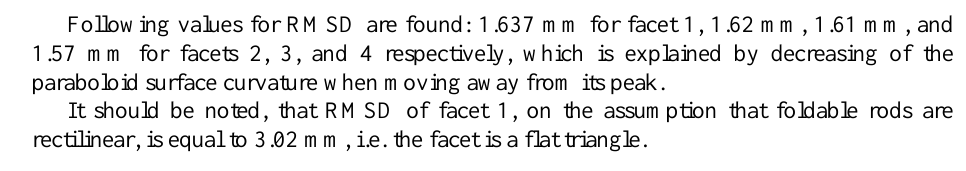
Fig. 16. Distribution of RMSD value along the module surface.